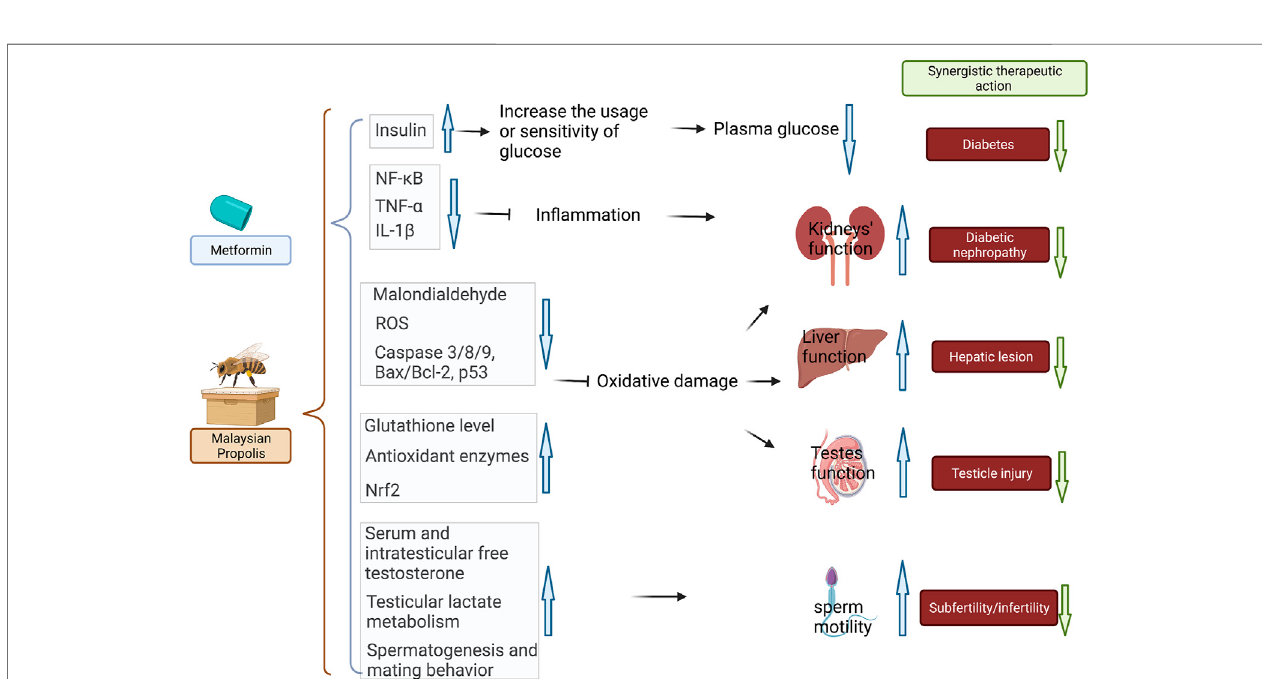
FIGURE 4 | Combined therapy of Malaysian propolis and metformin achieved the most prominent results in treating diabetes, diabetic nephropathy, attenuating hepatic, testicle injury, and subfertility/infertility in diabetic mice in comparison to the mono-therapeutic interventions. The possible mechanistic actions in attenuating hyperglycemia and diabetes-related renal, hepatic, and testicle damage were related to 1) increased insulin sensitivity and glucose uptake; 2) reduced in fl ammation via NF- κ B pathway; 3) antioxidant and reduced oxidative damage via activating Nrf2-regulated antioxidant genes. The therapeutic bene fi ts for subfertility and infertility were related to regulated serum, intratesticular free testosterone, testicular lactate metabolism, and spermatogenesis and mating behavior. Black arrows represent the action of metformin in the combination, whereas brown arrows represent the action of propolis.